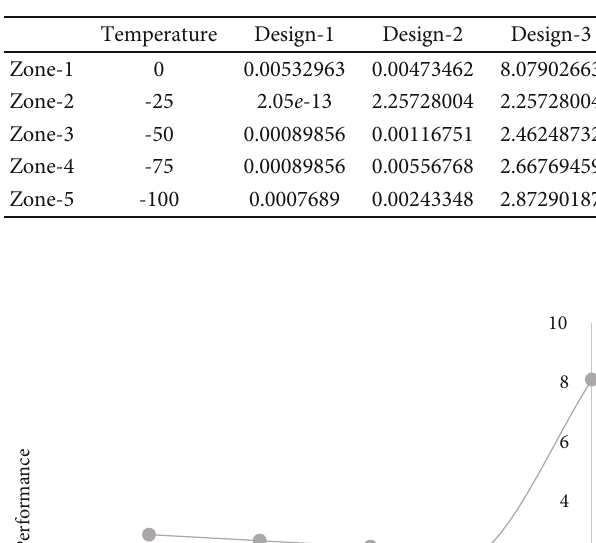
Figure 29: Performance in fl uencing parameters of Table 7: Operational zones vs. propeller e ffi ciency.